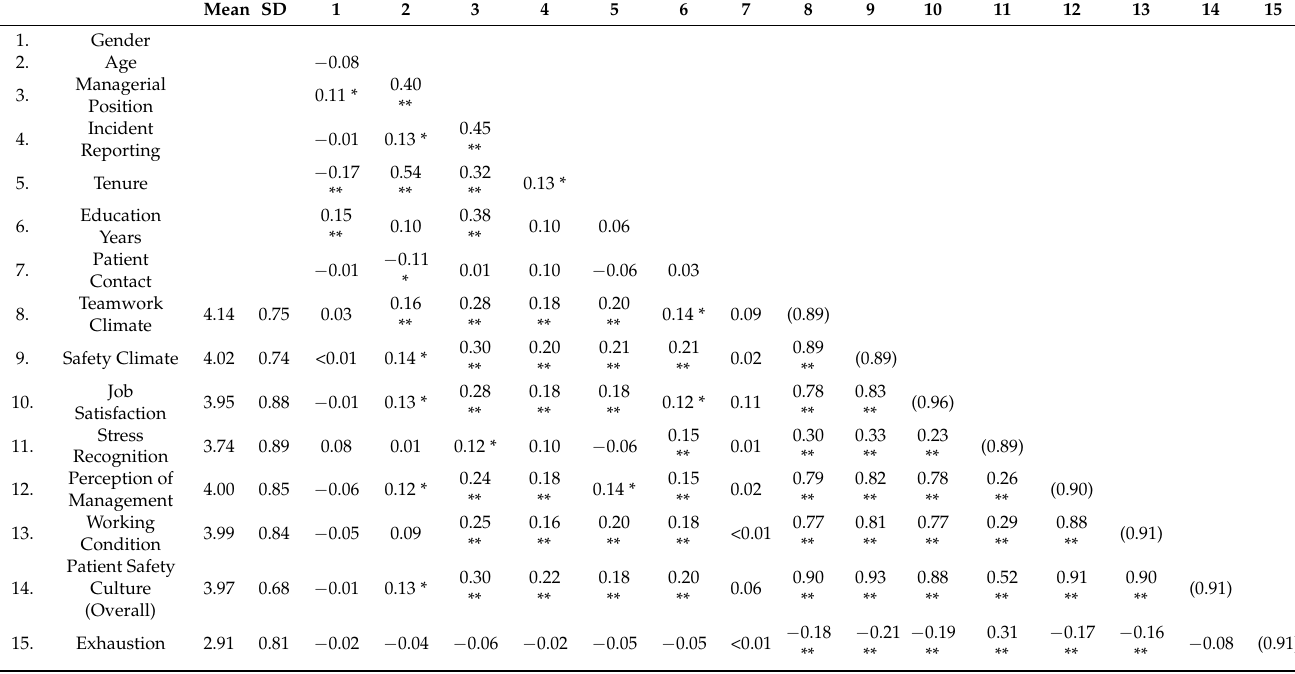
Table 7. Means, standard deviations and correlations among the study